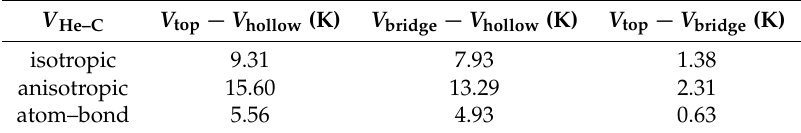
Table 4. Relative difference in V He–C ( z ) between the three symmetric sites (Figure 1b). Results are reported at z = z e (Table 3b). Results are reported only to two decimal places.